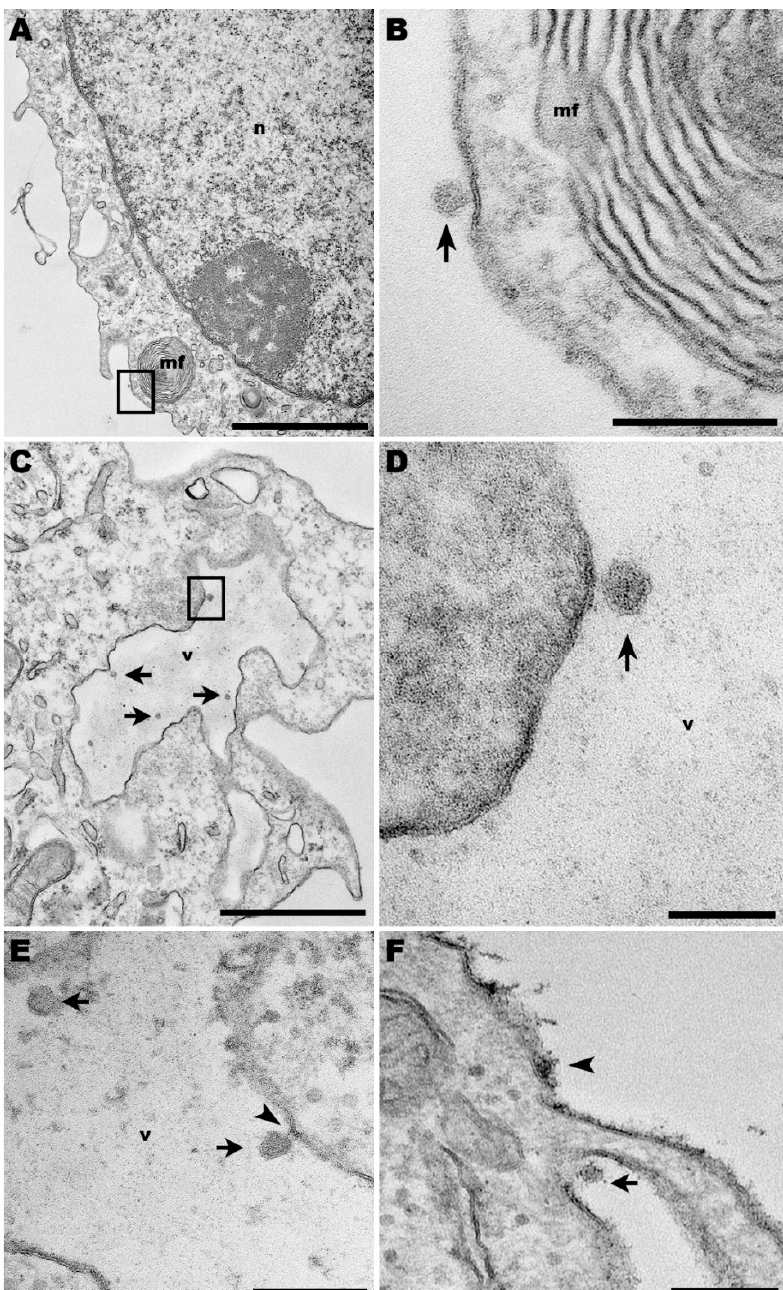
Figure 1. Transmission electron microscopy of macrophages infected with Phlebovirus ICOV. ( A , B ) ICOV particle on the surface of an infected macrophage from C57BL/6 mice (arrow), near of a myelin figure (mf) at the periphery of the cell (inset). ( C , D ) Inside virus-infected macrophages, ICOV (arrows and inset) were observed within large vacuoles (v). (n) nucleus. ( E ) Virus-containing vacuoles (v) displayed ICOV in the lumen (arrows) or linked to the vacuole membrane, through a membrane belt (arrowhead). ( F ) Viruses (arrow) were also observed in canyons of cell membrane projections. Bars: ( A ) 2 µ m; ( B , E , F ) 200 nm; ( C ) 1 µ m; ( D ) 100 nm. ICOV was also observed in canyons adjacent to cell membrane protrusions (Figure